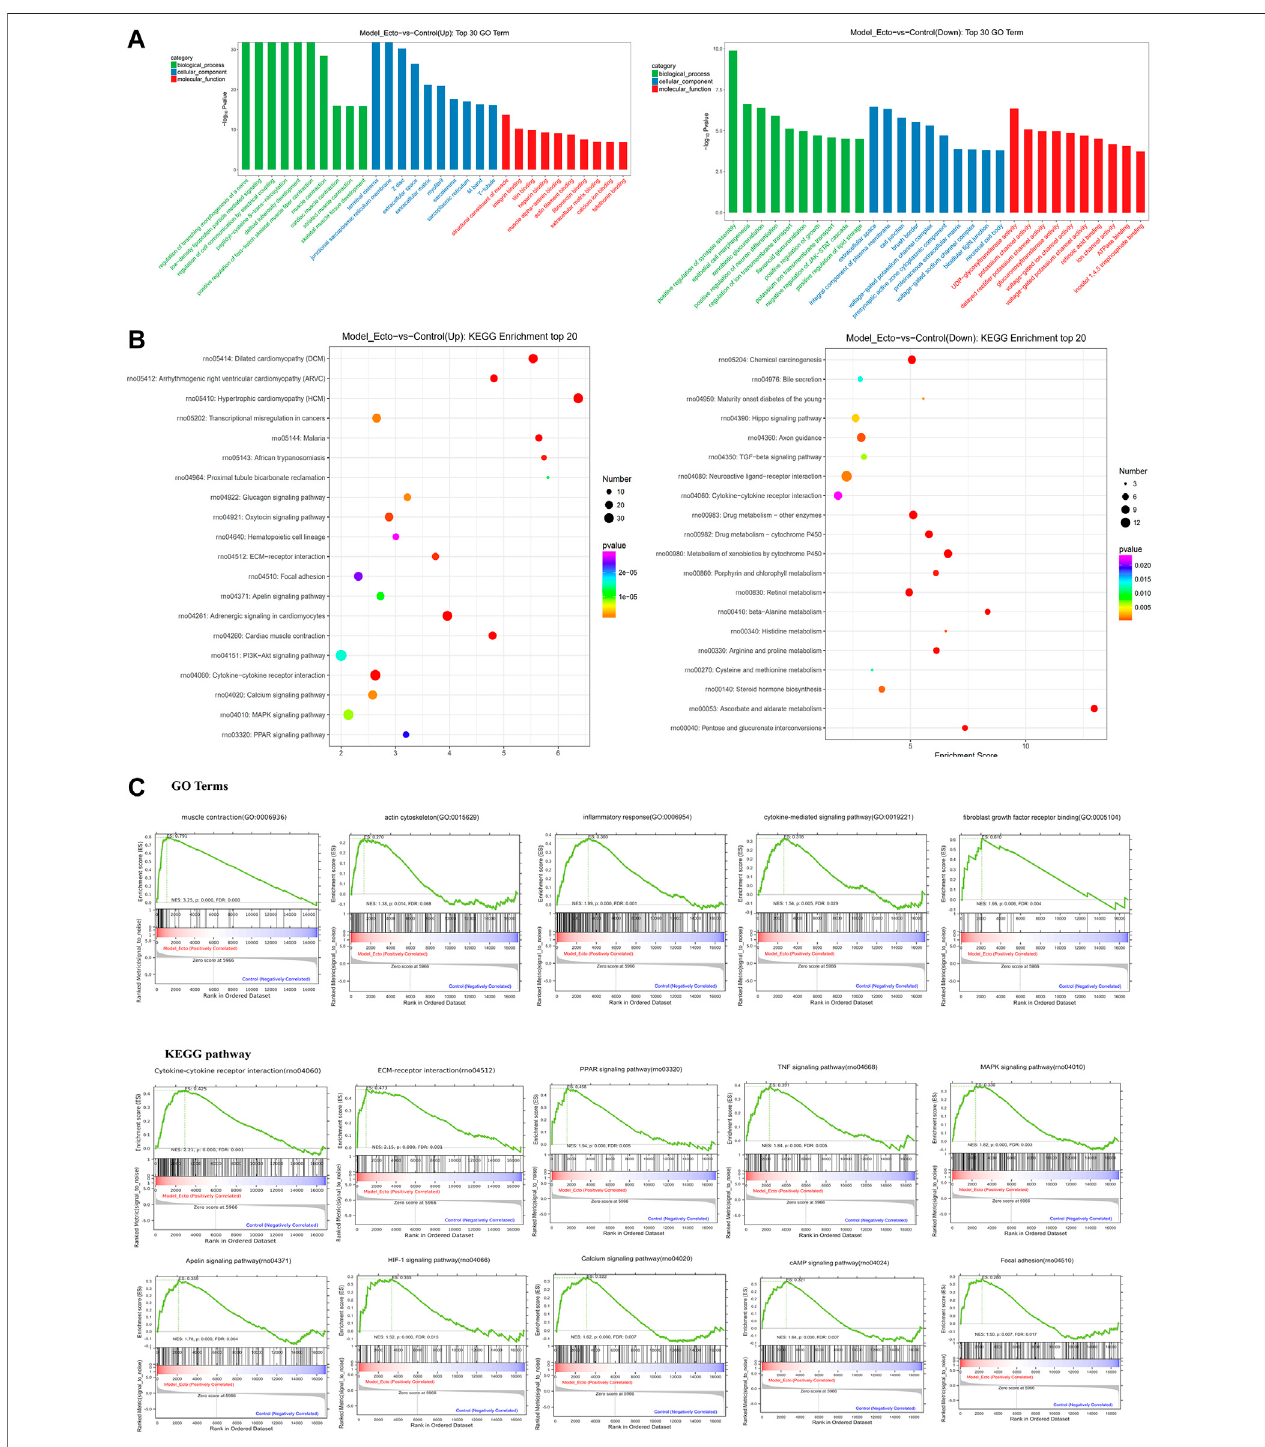
FIGURE 6 | RNA-sequencing reveals the characteristic of endometriosis rat models induced by autotransplantation. Transcriptome characteristics of endometriosis model rats were found through comparing the ectopic endometrium in model rats and the eutopic endometrium in control group rats. (A) Results of GO enrichmentanalysisforupregulatedDEGsanddownregulatedDEGsreversedbyELCectopicendometriumgroupsandmodelectopicendometriumgroups. (B) KEGG analysisofupregulatedanddownregulatedgenes.KEGGpathwayanalysisofupregulatedanddownregulatedgenesintheectopicendometriuminratmodels vs. control eutopic endometrium. The gene ratio refers to the ratio of the number of target genes associated with a KEGG pathway to the total number of genes in the pathway. (C) GSEA in endometriosis rat models showed enrichment of GO analysis and KEGG pathway. The normalized enrichment score (NES), p -value, and false discovery rate (FDR) are indicated for each gene set. GSEA revealed a signi fi cant enrichment of gene signatures associated with endometriosis ( p < 0.05).